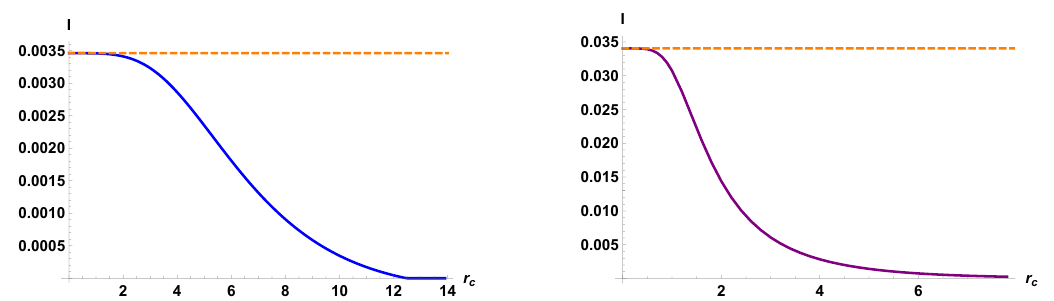
Figure 14 . HMI as a function of r c for: Left ) ‘ = 10 , h = 5 and d e = 3 . Right ) ‘ = 5 , h = 1 and d e = 4 . The orange dashed curves indicate the HMI for the zero cutoff case given in eq. (4.9). It is obvious that the HMI depends on the cutoff, and is a decreasing function of r to zero when r c → ∞